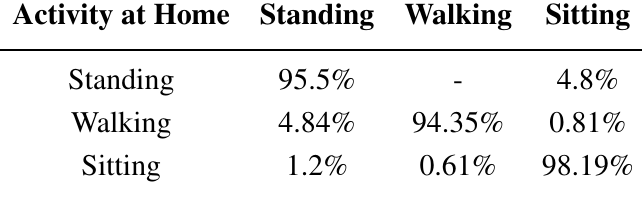
Table 3. Activity Recognition Accuracy for Office.